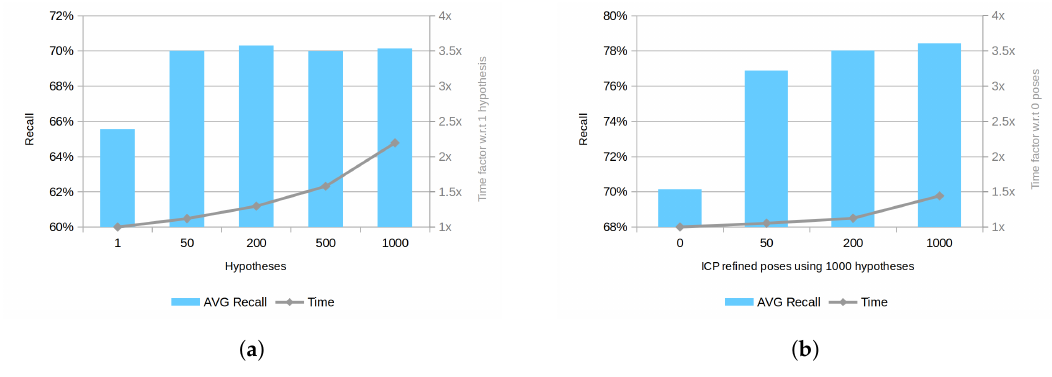
Figure 11. Performance comparison using different post-processing parameters. ( a ) comparison using a different number of hypotheses, no ICP or verification step is applied; ( b ) comparison refining different number of poses for 1000 hypotheses, any verification step is applied. Note: left axis shows recall value in percentage and right axis shows time